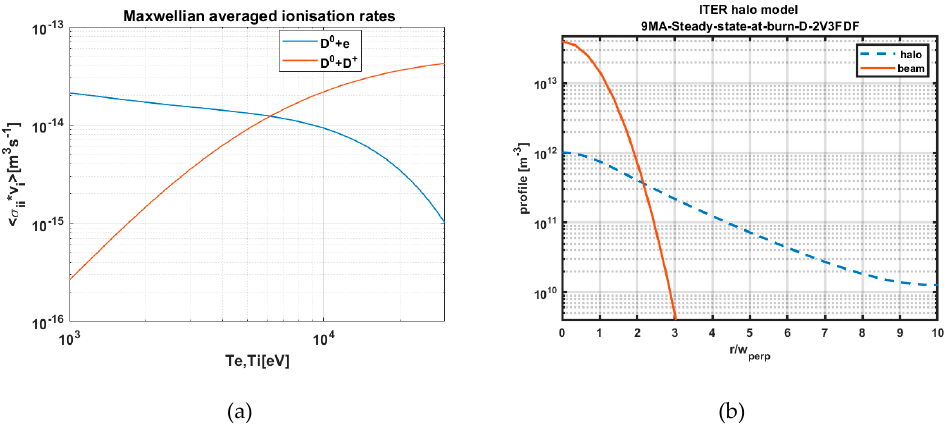
Figure 9. ( a ) Electron- and Ion-ionisation rates used for Halo model; ( b ) Halo and beam density profile, ITER, DNB 100keV/amu, 9MA scenario;